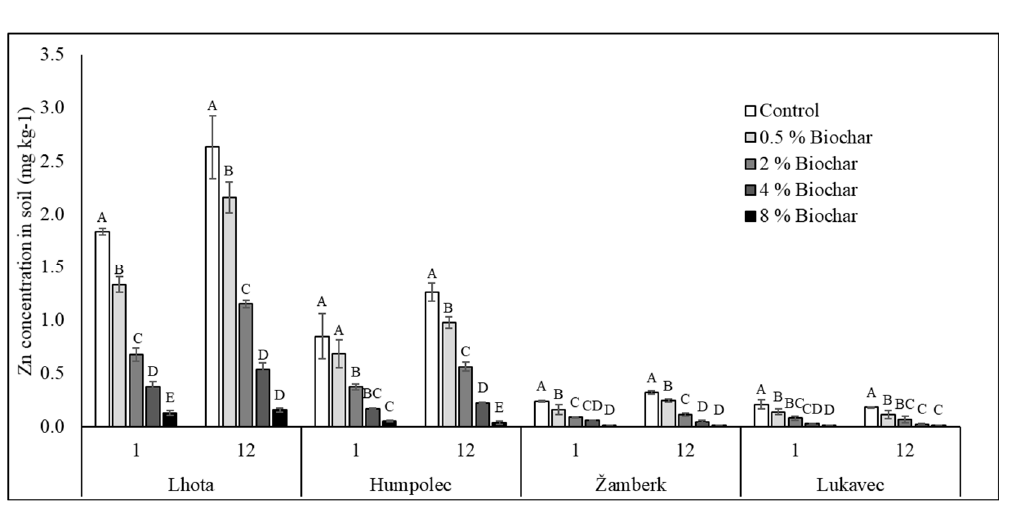
Figure 3. Effect of biochar addition on soil-available content of Zn (mg kg − 1 ). On the horizontal axis, 1 and 12 stand for 1st and 12th week of incubation period or sample collection time, respectively. Kbely soil is not presented due to the available content of Zn is below detection limit of ICP used for the measurement (below 0.02 mg kg − 1 ). Di ff erent capital case letters represent significance di ff erence ( p < 0.05) of treatments within same sample collection time of same soil. Table 6. Pearson correlation coe ffi cient of available Zn content with soil pH, CEC, and exchangeable Ca 2 + and K + after addition of four levels of biochar (0.5%, 2%, 4%, and 8%) at the 12th week of incubation. Zn (n = 5) Kbely